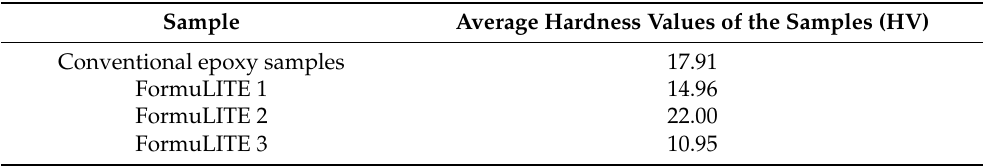
Table 4. Average hardness values of the conventional and bio-based epoxies.